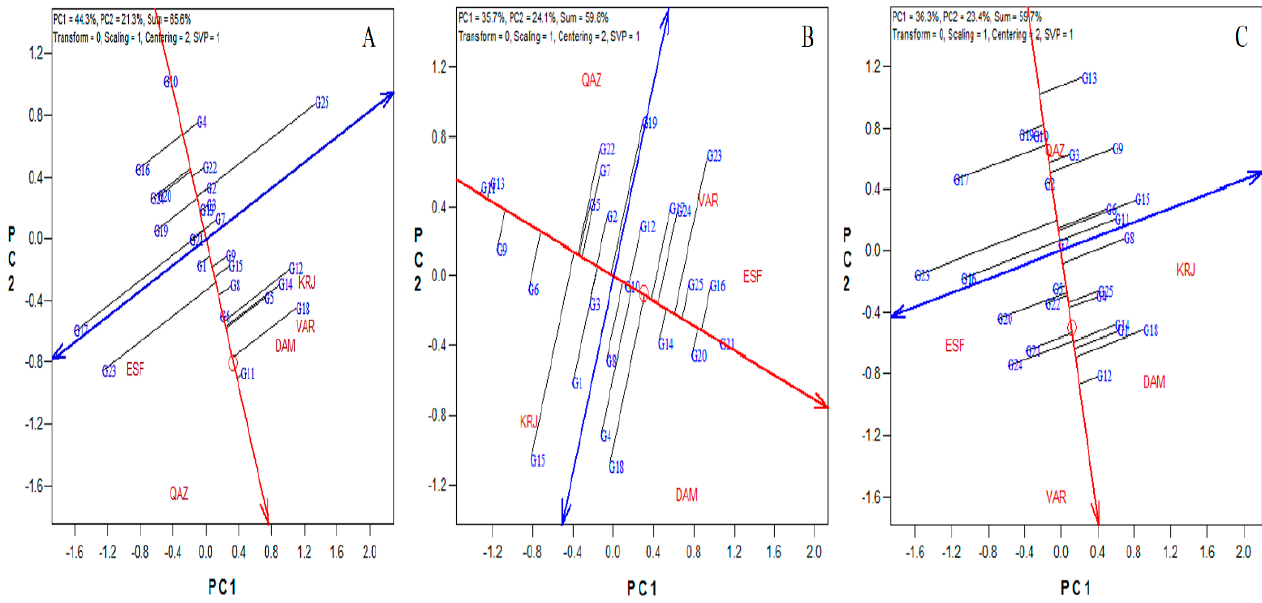
Figure 2. The average genotype coordination view for evaluating 25 wheat cultivars in five environ- ments simultaneously classifies cultivars . ( A ): First year, ( B ): Second year, ( C ): Average of two